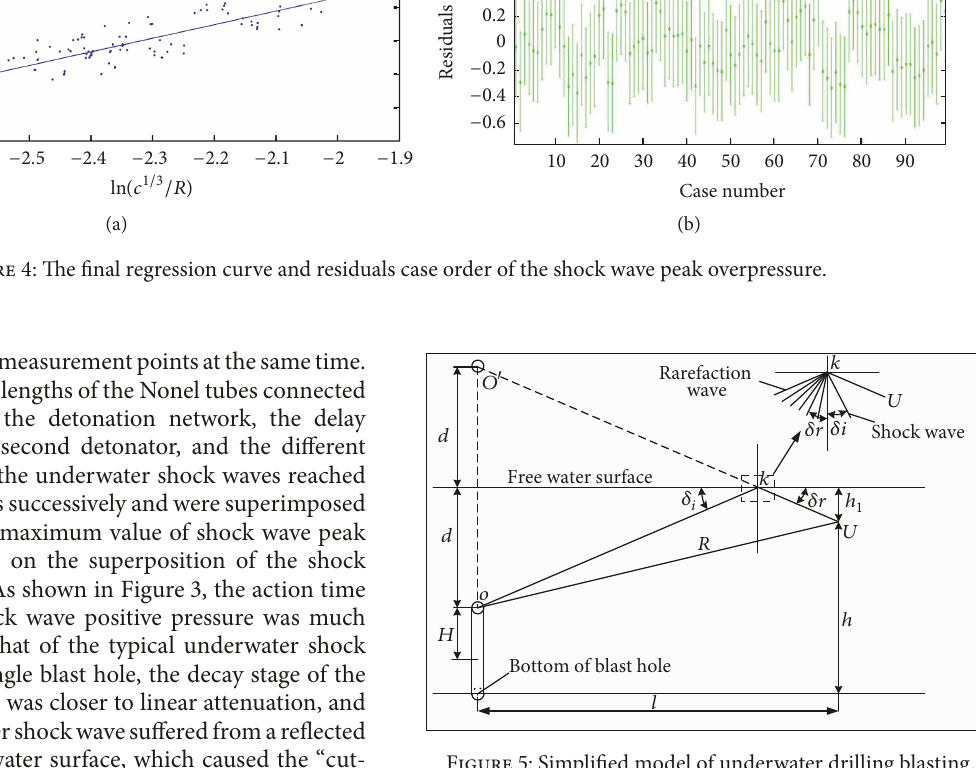
Figure 5: Simplified model of underwater drilling